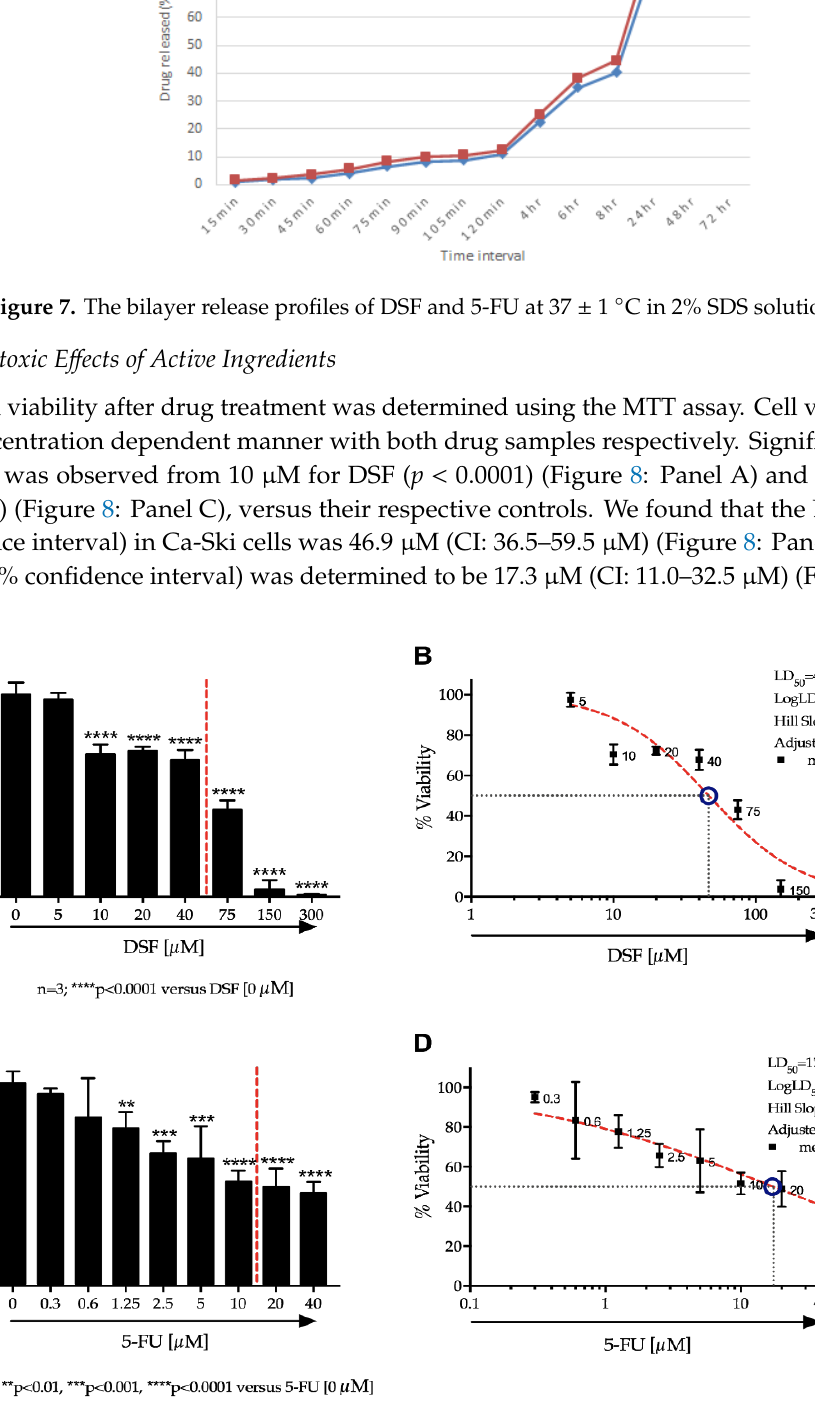
Figure 8. The effects of DSF (Panel A , Panel B ) and 5-FU (Panel C , Panel D ) on the percentage viability of Ca-Ski cells.